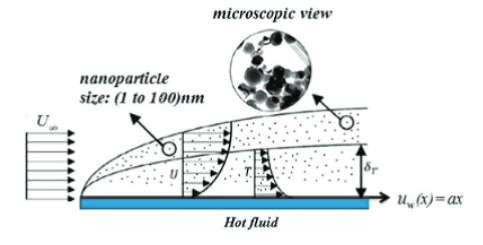
Figure 1. Geometry of the flow under